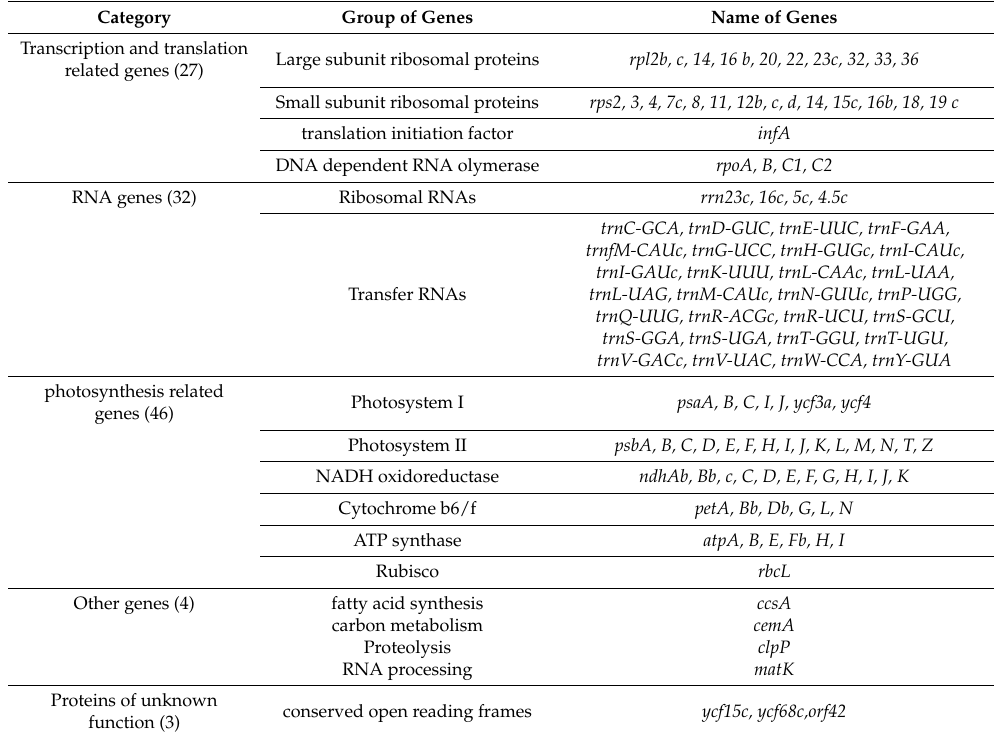
Table 2. Genes found in the assembled broomcorn millet chloroplast genome.